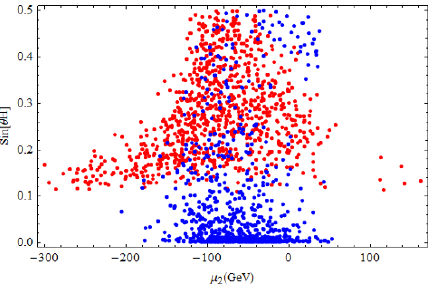
Figure 10 . The v c =T c > 1 viable points in the plane of sin (cid:18) H over (cid:22) 2 for one step(red) and two-step(blue) phase transition for the low mass m h